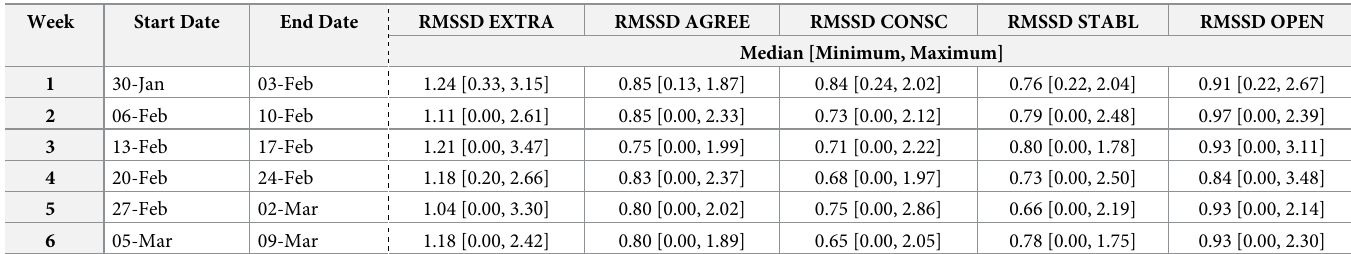
Table 1. Summary of weekly EMA data by personality